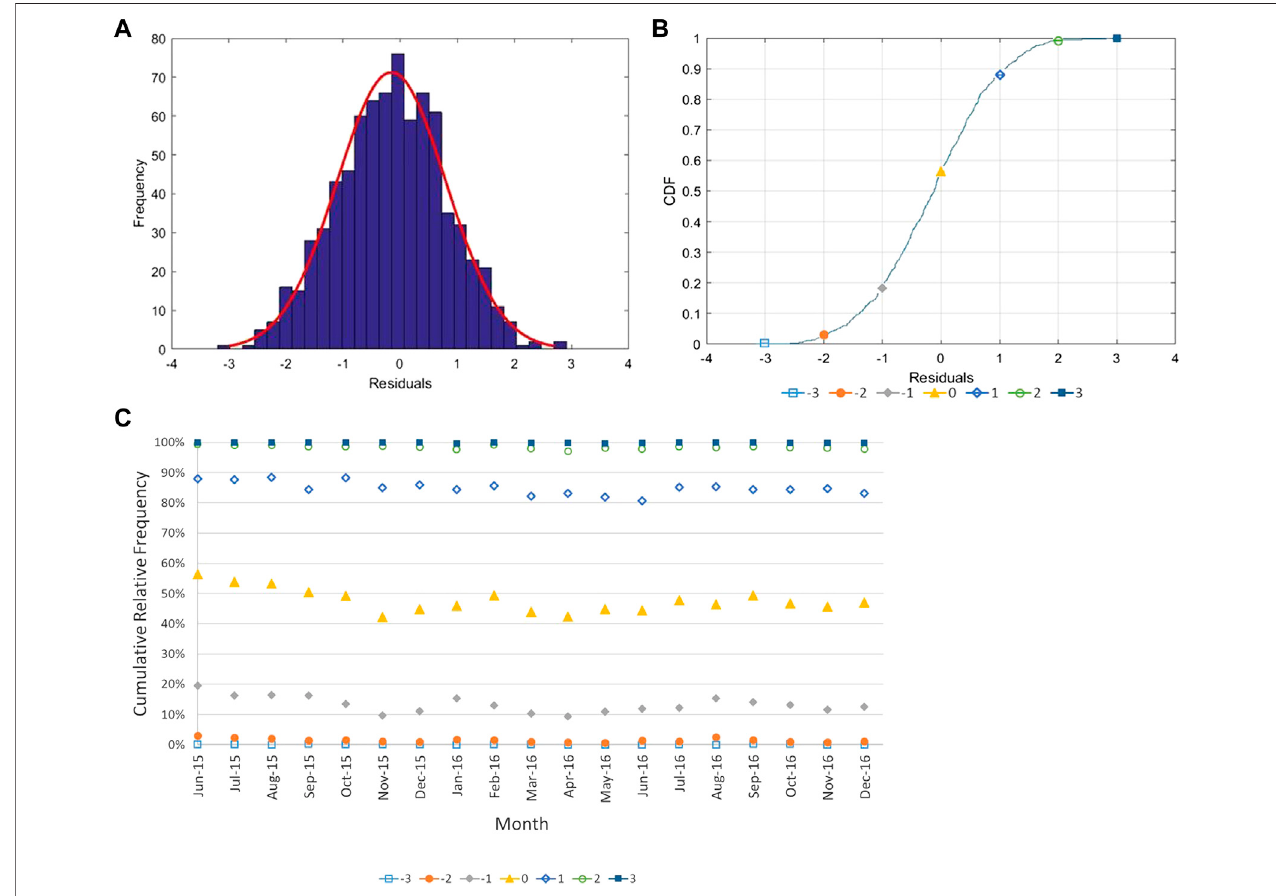
FIGURE 12 | (A) Frequency distribution and (B) Cumulative distribution function of residuals for June 2015 at the controlling location (CL) of west girder (C) Key points of cumulative distribution function for monthly residuals at controlling location (CL) of west girder.